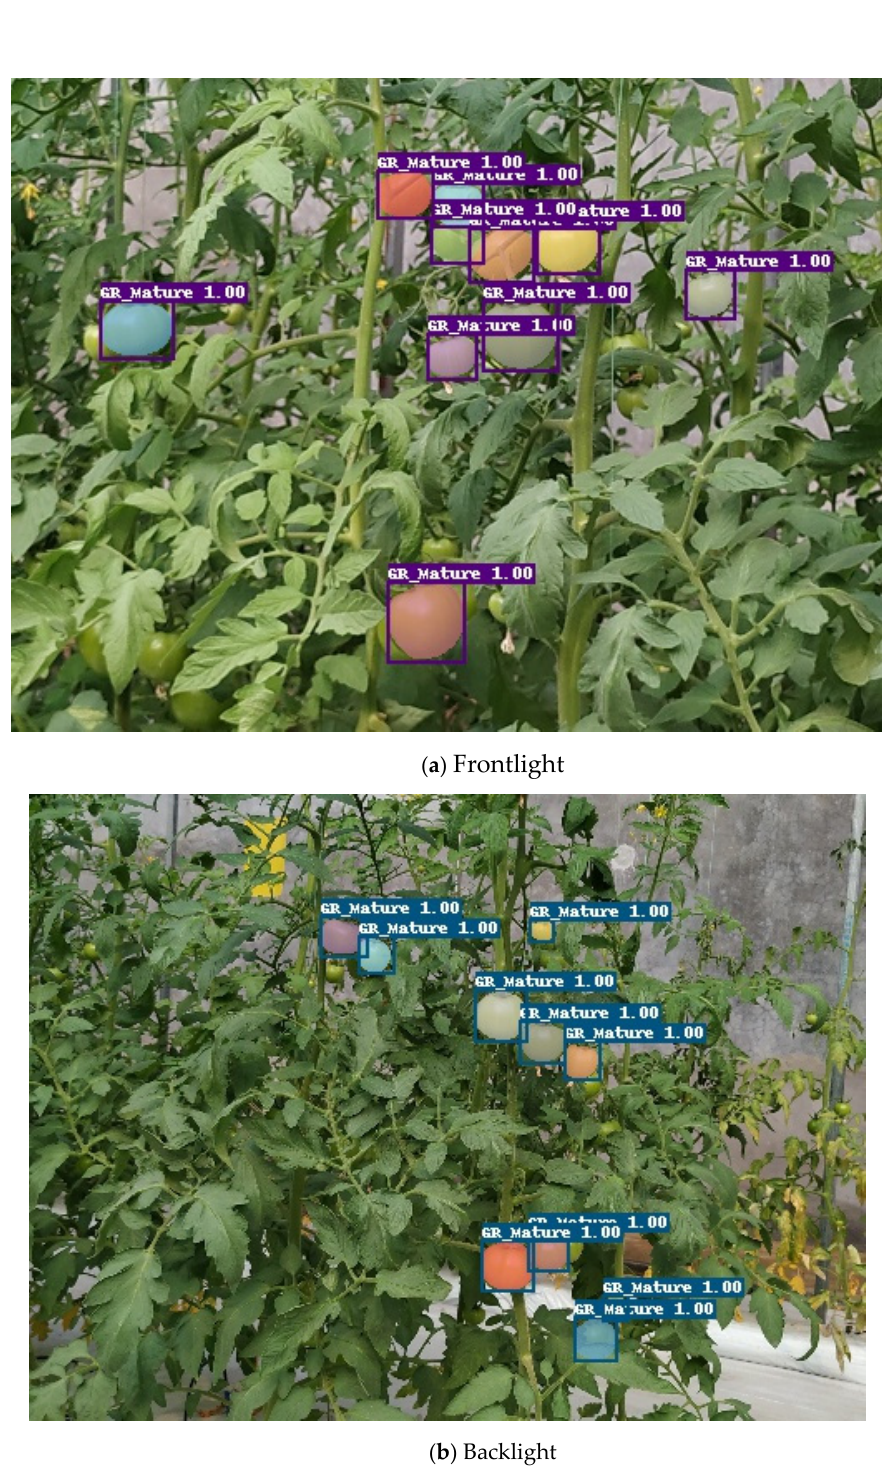
Figure 10. Results of the data imbalance test on mature green tomatoes.